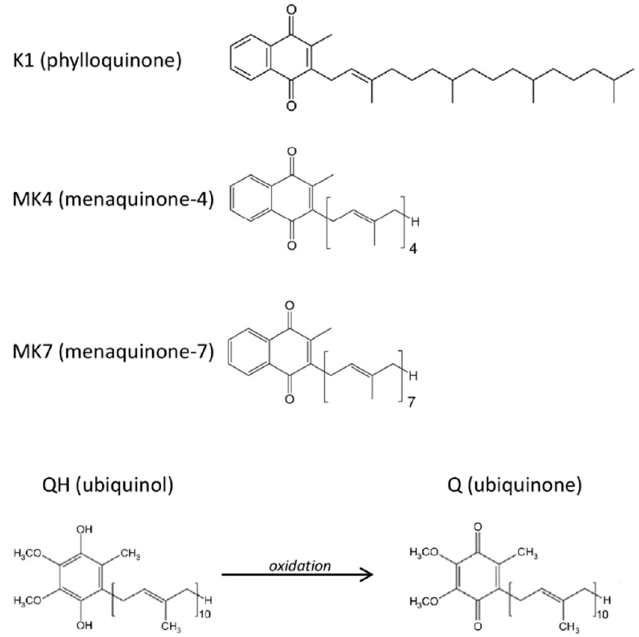
Figure 1. Molecular structures of the tested quinones.